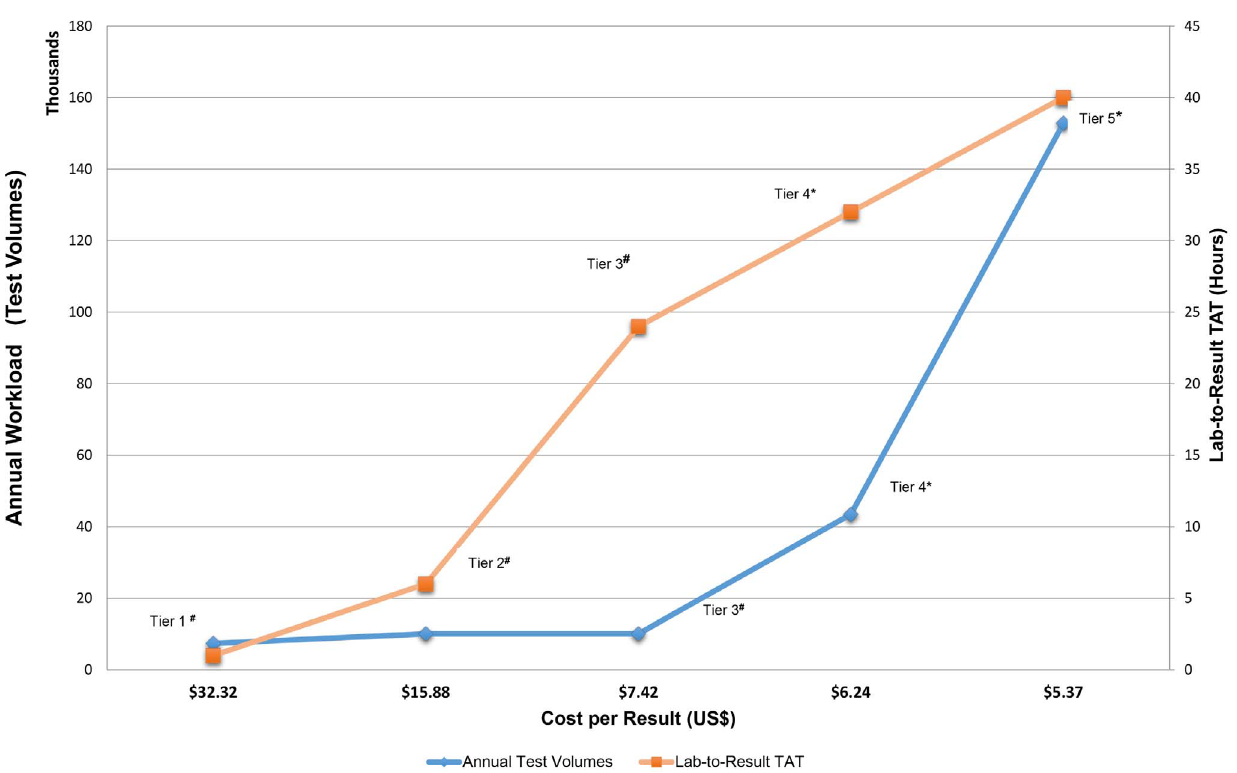
Fig. 2. Relationship between costs, TAT and volumes. Comparison of expected laboratory-to-result turnaround-time (LTR-TAT, orange) and annual CD4 workload (test volumes, blue), per tier, versus cost-per-result (in US$). Tier 3, 4 and 5 laboratories with higher volumes have a lower cost but associated longer LTR-TAT, versus the POC tiers (Tiers 1 and 2) with fast TAT but cost 2–4 times more. Tier-3 emerges with the lowest cost despite lower workload but still meets , 24-hour LTR-TATand fulfils NDOH treatment algorithm requirements [5] where patients are requested to return for CD4 results at 7 days. (*Tiers 1, 2 and 3 are proposed services, #Tiers 4 and 5 are existing service